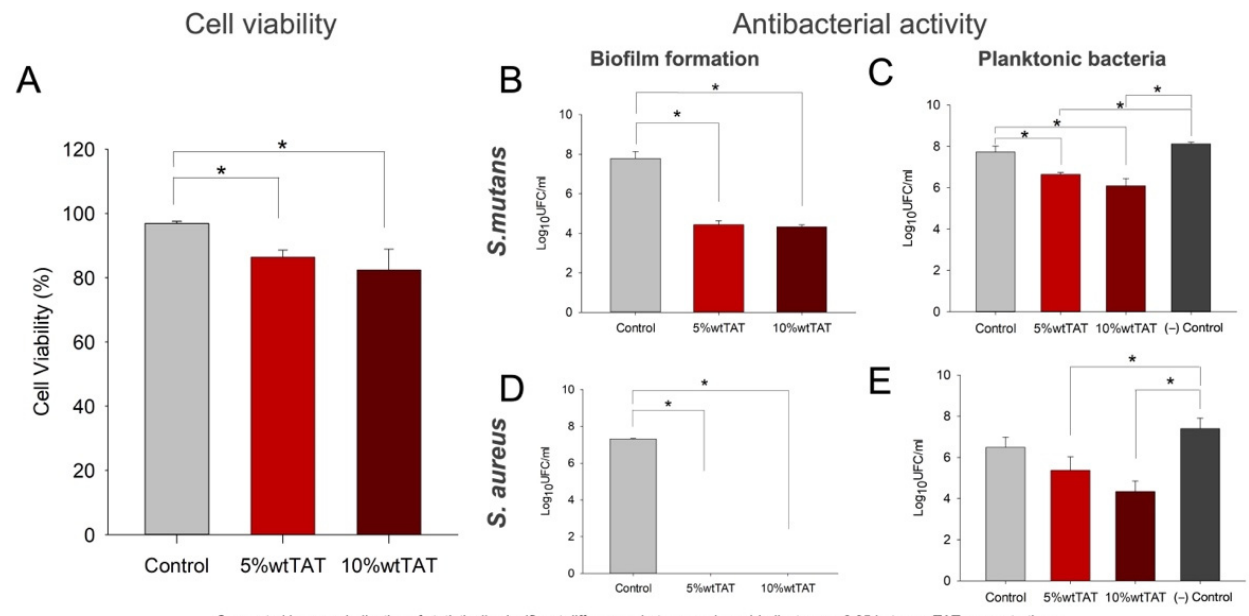
Figure 4. Cell behavior and antibacterial activity analysis. ( A ) Cell viability in MC3T3-E1 cells after 72 h of culture via SRB analysis. Antibacterial activity of experimental barrier membranes against S. mutans ( B , C ) and S. aureus ( D , E ) in log10 CFU/mL. Bars are a description of average values, while error bars represent standard deviations. Connected bars are indicative of statistically significant differences between values. * Indicates statistically significant differences between TAT concentrations and # between immediate and longitudinal